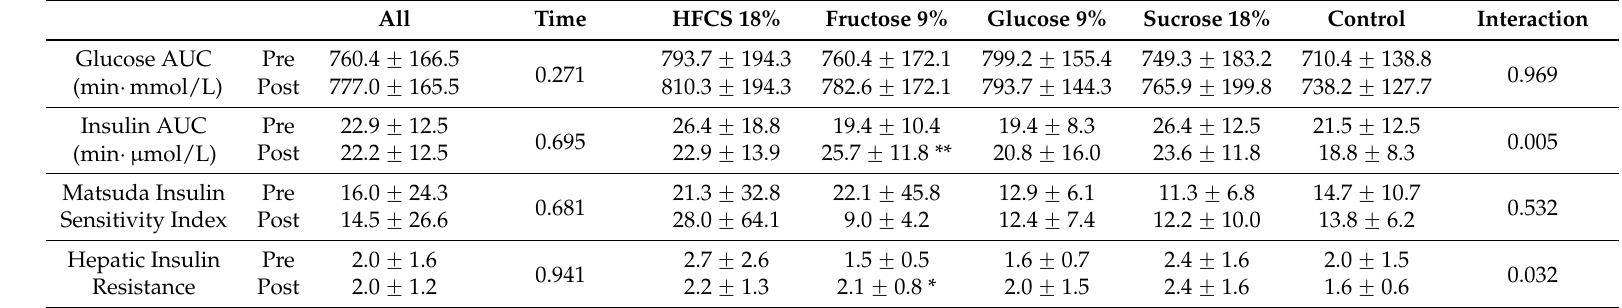
Table 5. Oral Glucose Tolerance Measures obtained before and after ten weeks of daily consumption of sugar sweetened milk or unsweetened control milk. All Time Control Interaction Glucose AUC Insulin AUC